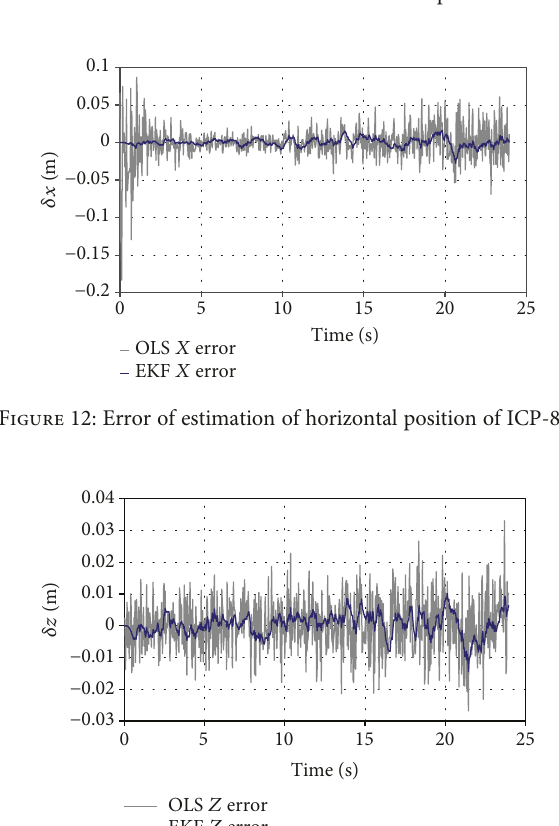
Figure 11: Simulated and estimated vertical component of wind.